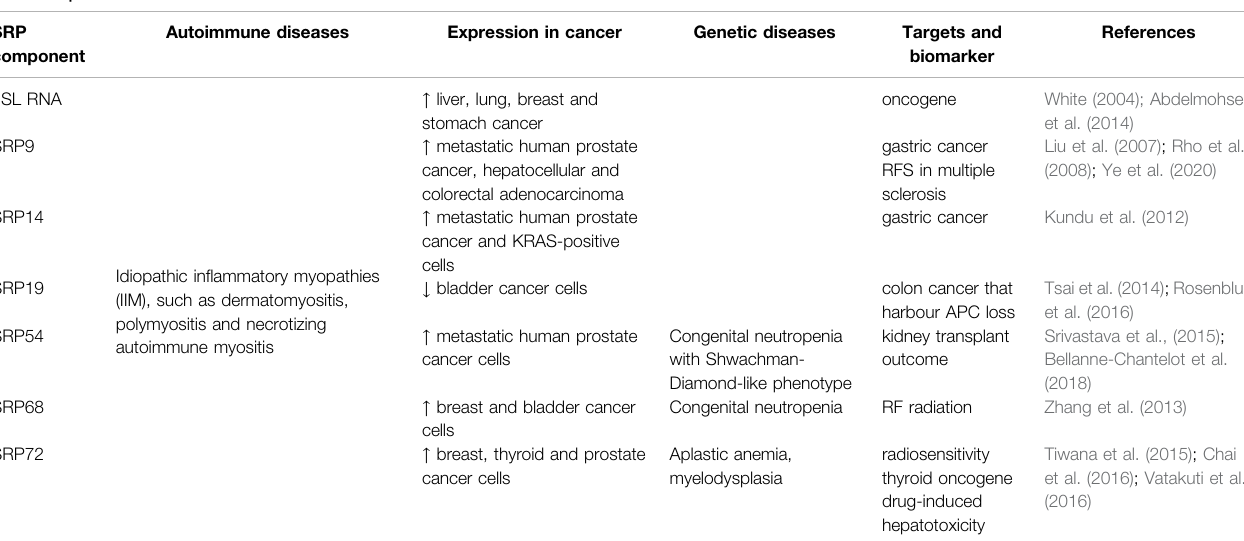
TABLE 2 | Diseases and biomarkers associated with SRP